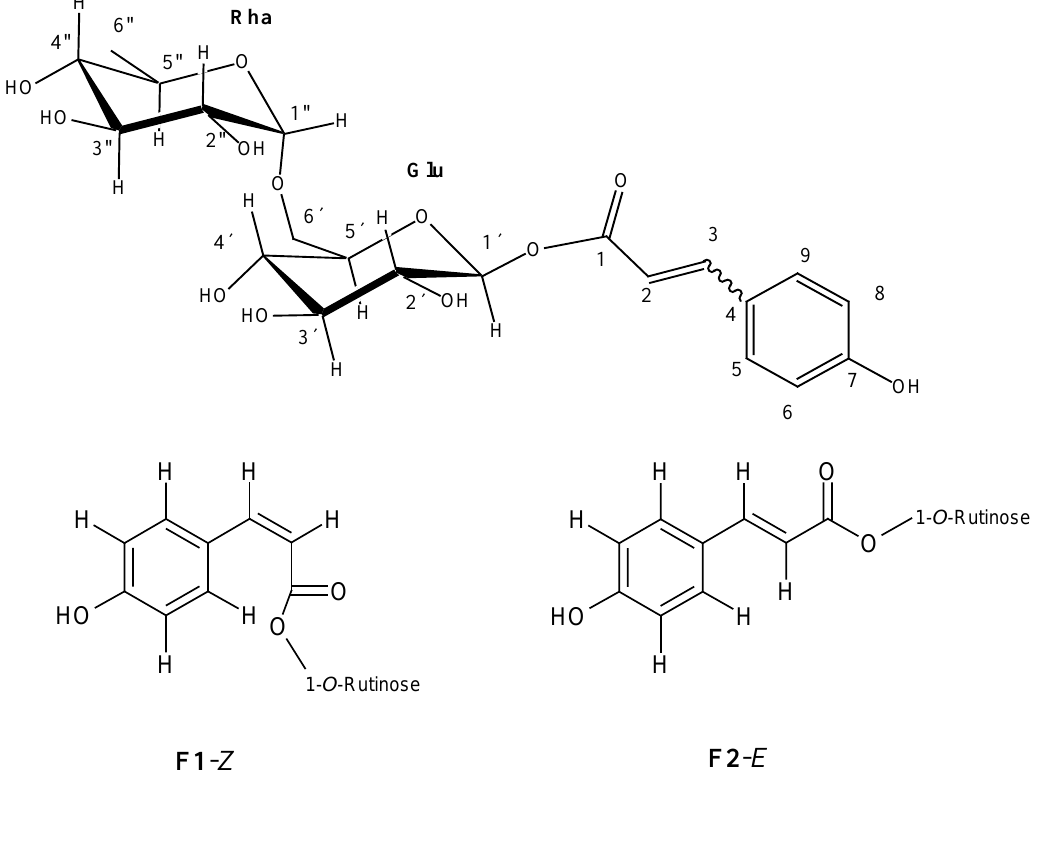
Figure 4 . Proposed structures for identified compounds F 1 -Z and F 2